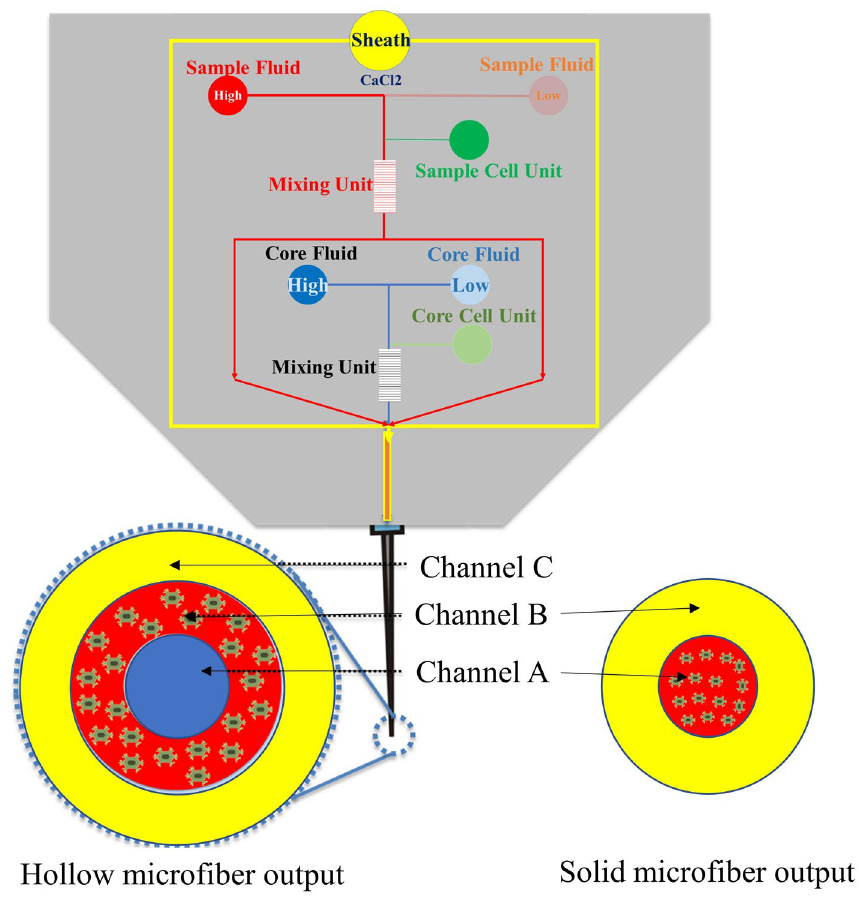
Figure 8. The microfluidic-based bioprinter system, ( a ) channel system design of the microfluidic printhead, ( b ) the whole bioprinting system